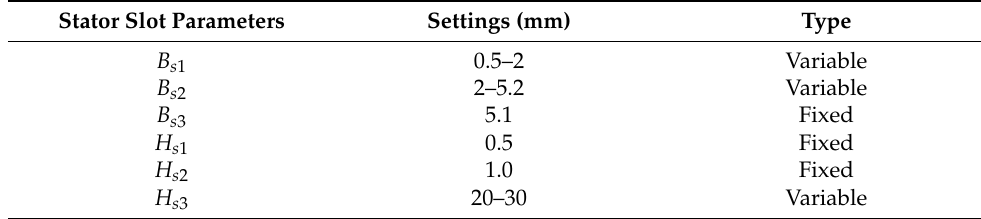
Table 3. Parameter settings of stator slot [9].